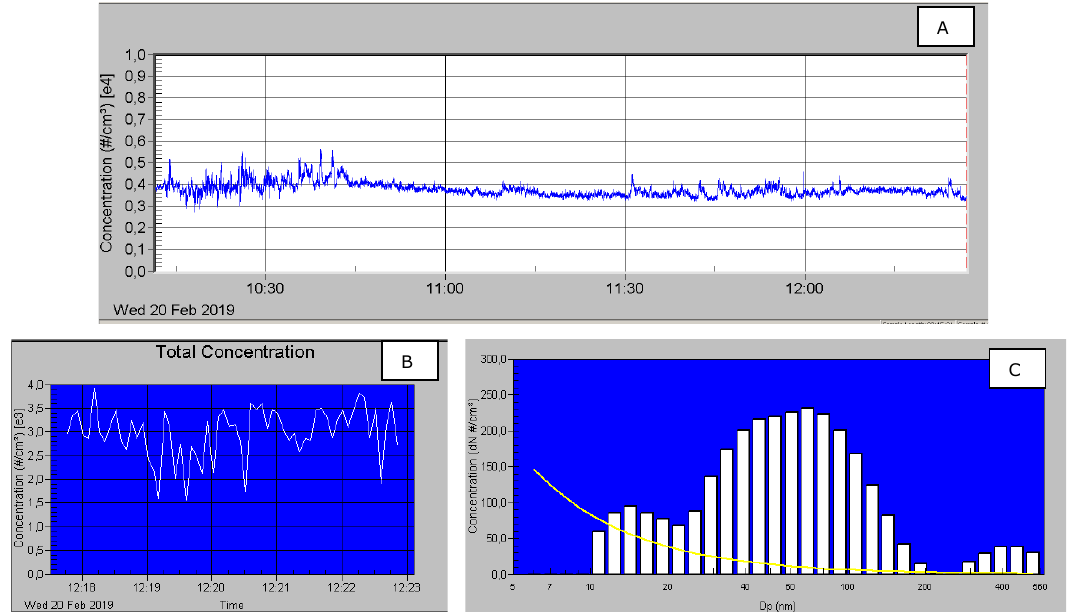
Figure 4 . Nanoparticles during PLA printing. A (CPC concentration), B (EEPS concentration), C (EEPS size distribution)